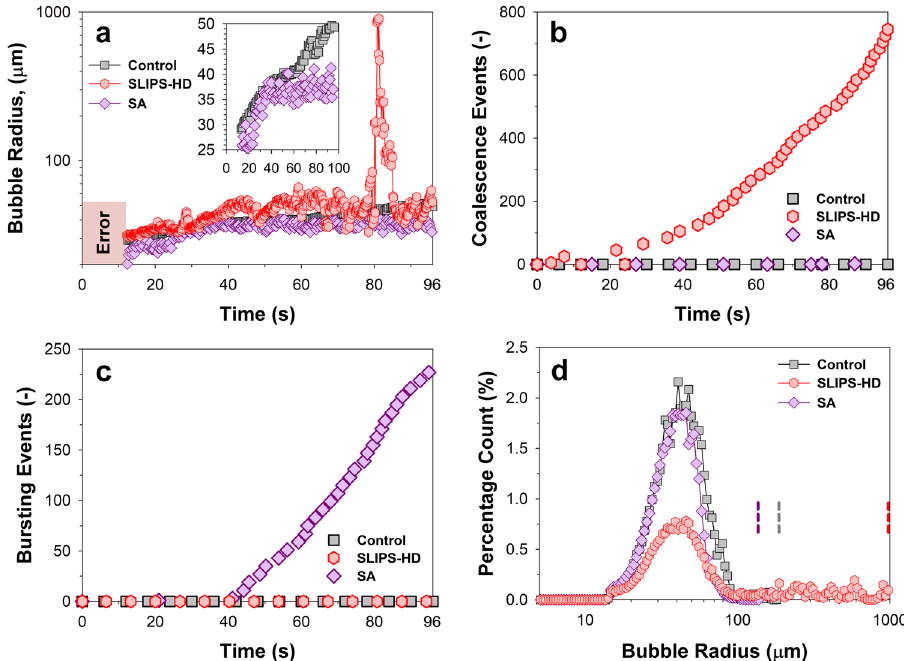
Fig. 2 Bubble dimensions with respect to time. Imaging at 2.5 cm below the maximum original foam height. Bubbles were analyzed over a surface area of 3.5 mm 2 , at the bubble-to-surface interface. The foam line recedes from view beyond 96 s for the fastest defoaming superamphiphobic surface. Control refers to unfunctionalized glass, SLIPS-HD refers to a slippery liquid-infused porous surface infused with hexadecane, and SA refers to superamphiphobic glass. a Average bubble radii with respect to time, showing a gradual rise in the control (inset, gray squares). Bubbles remained smallest for the superamphiphobic system. b Coalescence events observed in SLIPS. c Bursting events caused by the dissipation of a bubble during bubble-to-surface interaction were observed for the superamphiphobic surface. Observation of the fi rst bursting event is dependent on the region of observation. All bubbles were computationally tracked (see “ Methods ” ). d Analysis of the percentage count of bubble radii and areas over the entire 96 s duration (minus the fi rst 12 s) revealed persistently small bubbles in the control and superamphiphobic surfaces. The largest bubble radii in each system are represented with a dashed